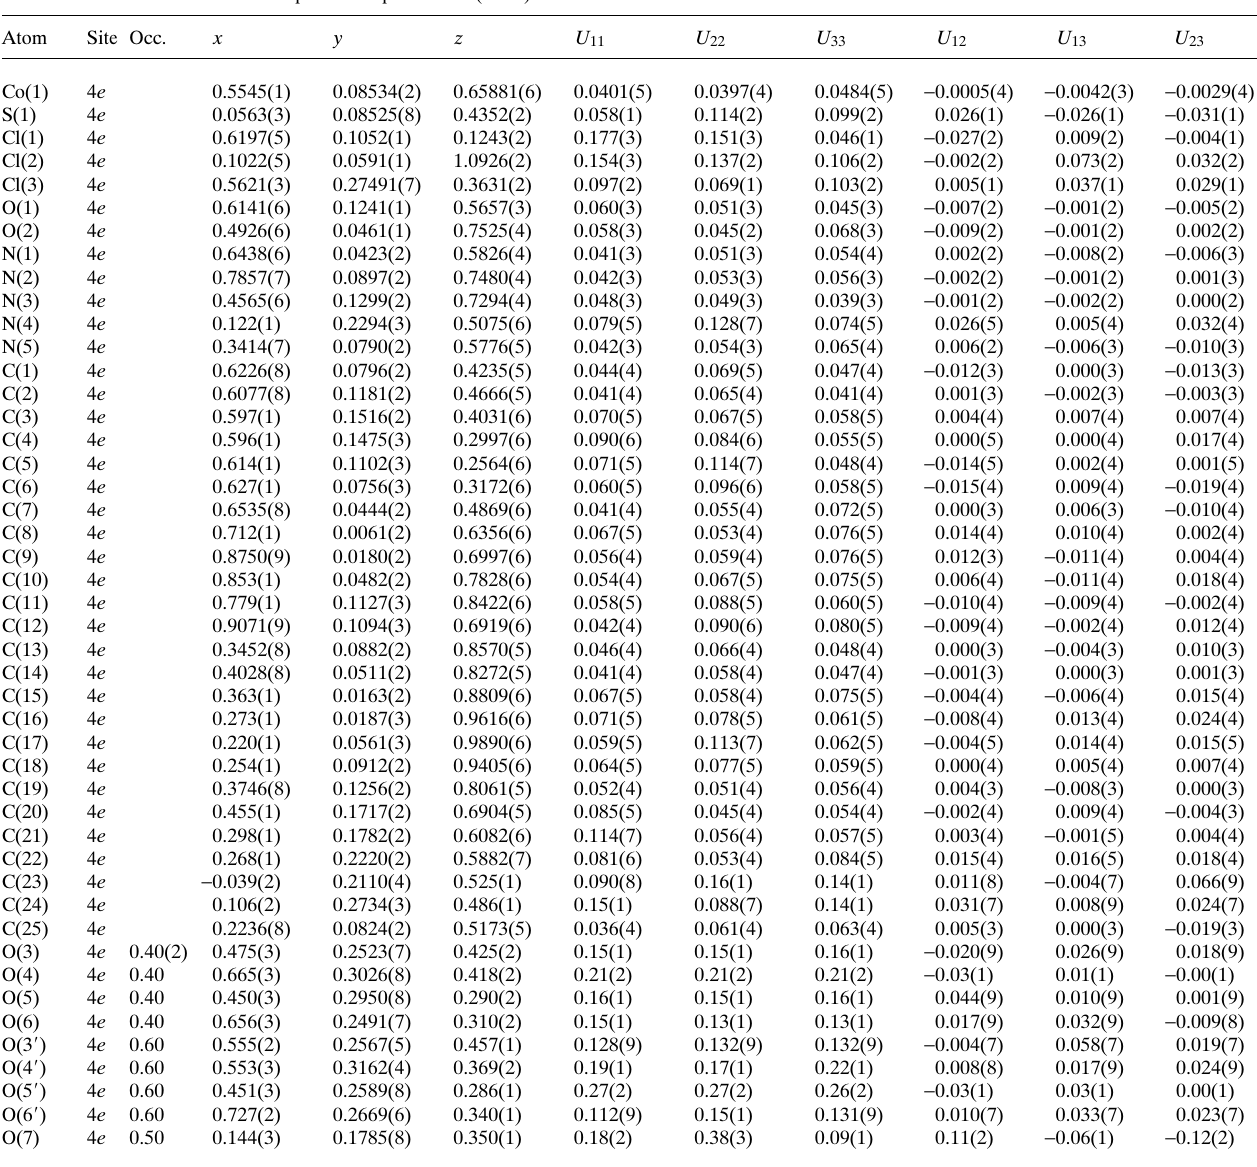
Table 3. Atomic coordinates and displacement parameters (in Å 2 ) .